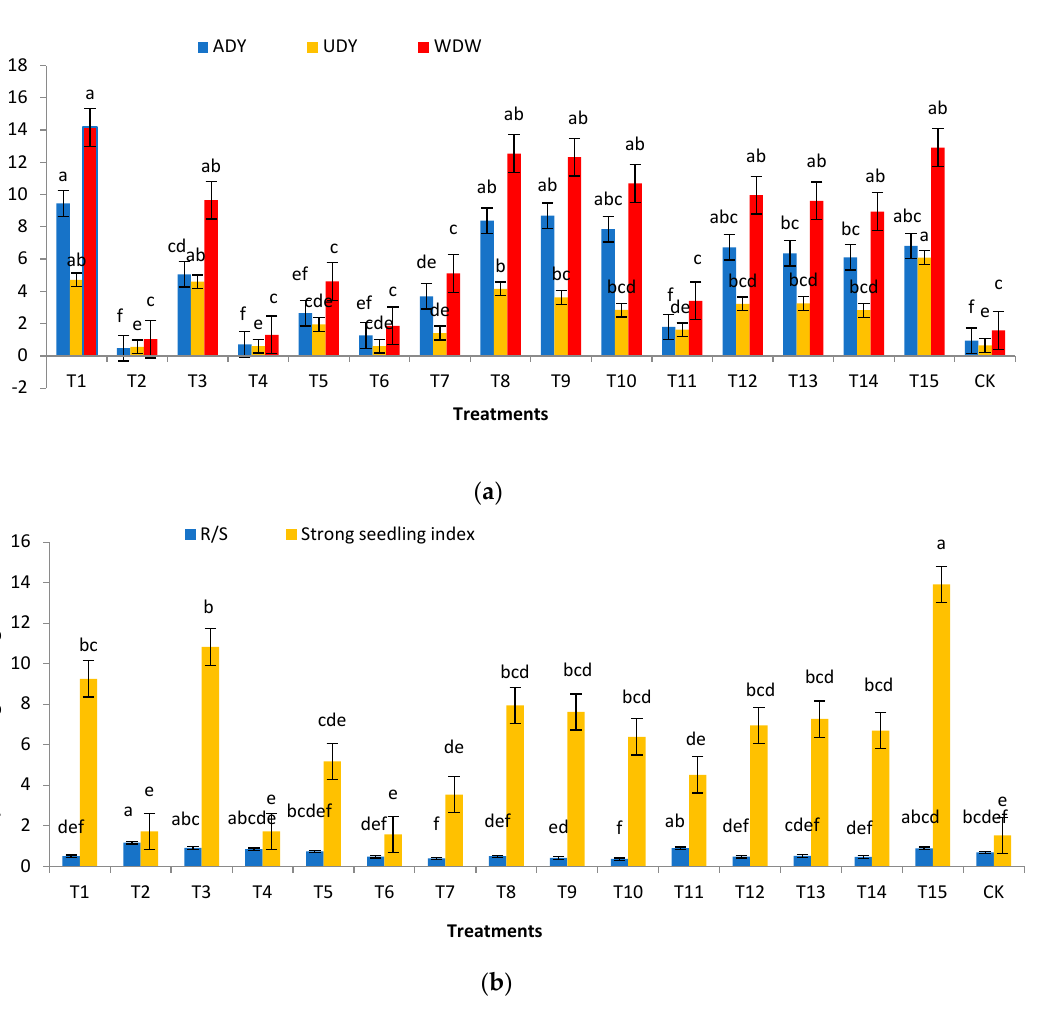
Figure 1. Growth characteristics and relative chlorophyll content of H. chrysanthus with different mixed substrates: ( a ) height (H, cm), ( b ) ground diameter (D, mm), ( c ) height–diameter ratio (H/D), ( d ) branch number, ( e ) relative chlorophyll content (SPAD value), and ( f ) survival rate (%). Signif- icant differences between treatments are indicated by different lowercase letters (Tukey’s HSD test; p < 0.05; mean ± SE).